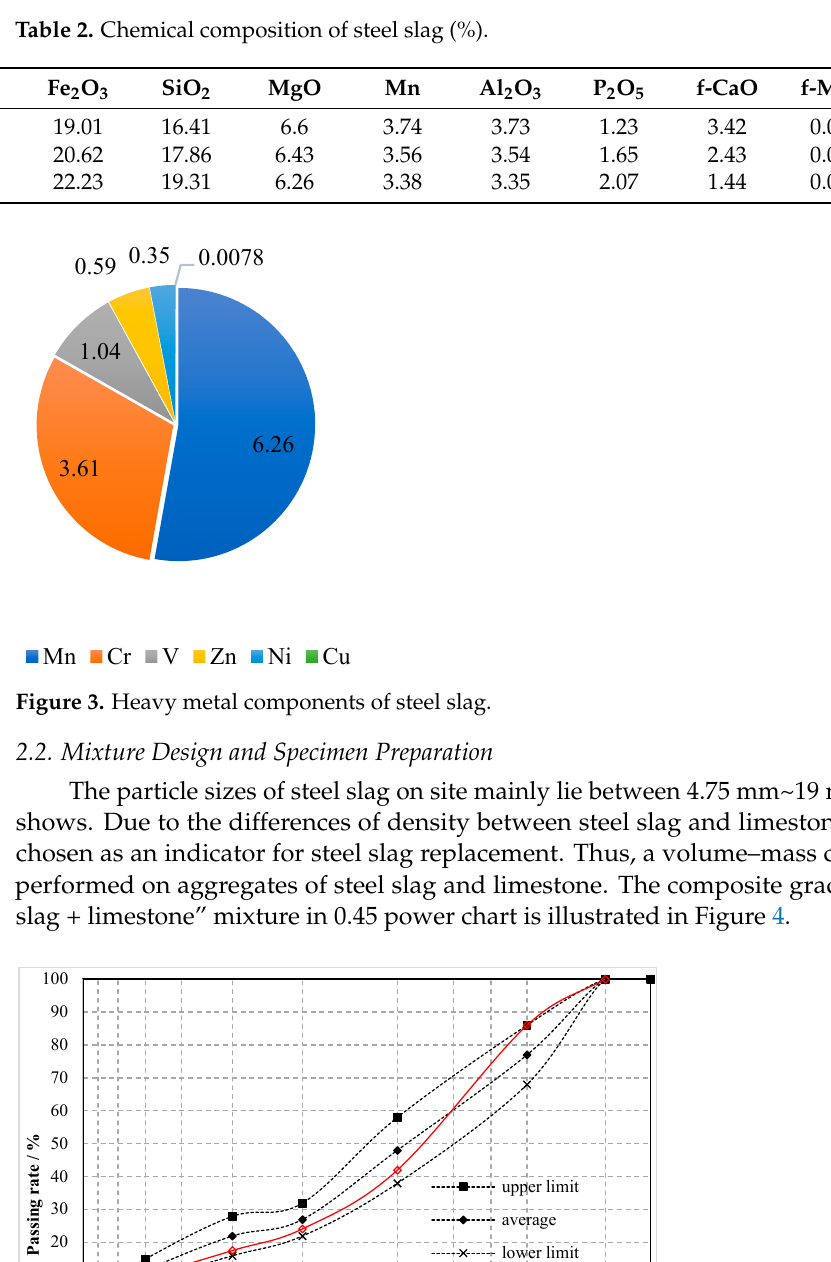
Table 3. OMC and MDD of different steel slag content and cement content.